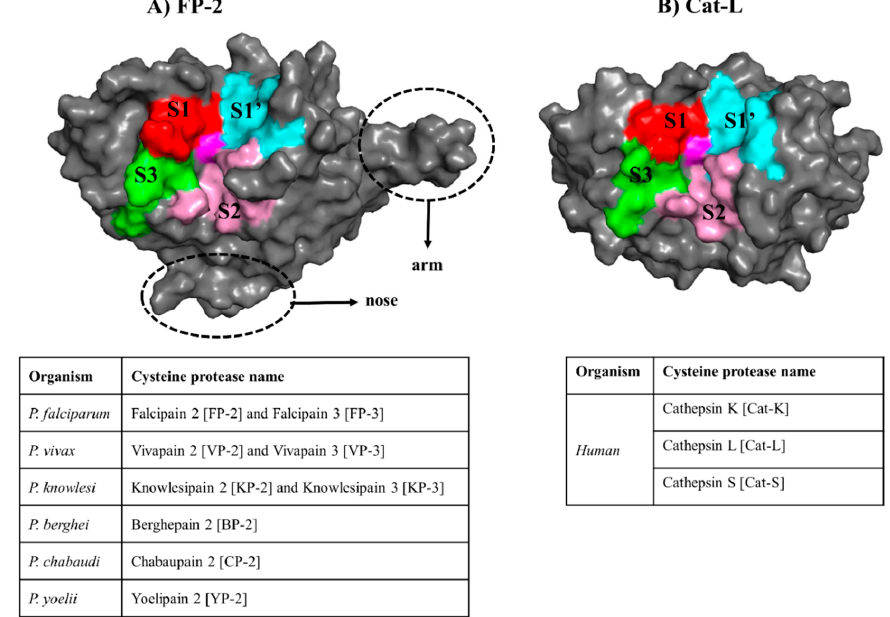
Figure 1. The general structural fold of ( A ) falcipains (FPs) and plasmodial homologs and ( B ) human cysteine proteases. The different subsites forming the “trench-like” active pocket are shown in red (S1), pink (S2), green (S3) and cyan (S1 ′ ). The central catalytic Cys residue is colored in magenta. The unique structural features (nose and arm) found only in plasmodial proteases are marked with a broken line. Tables present the name of the homologous FP-2 and FP-3 proteins from other Plasmodium species as well as the human